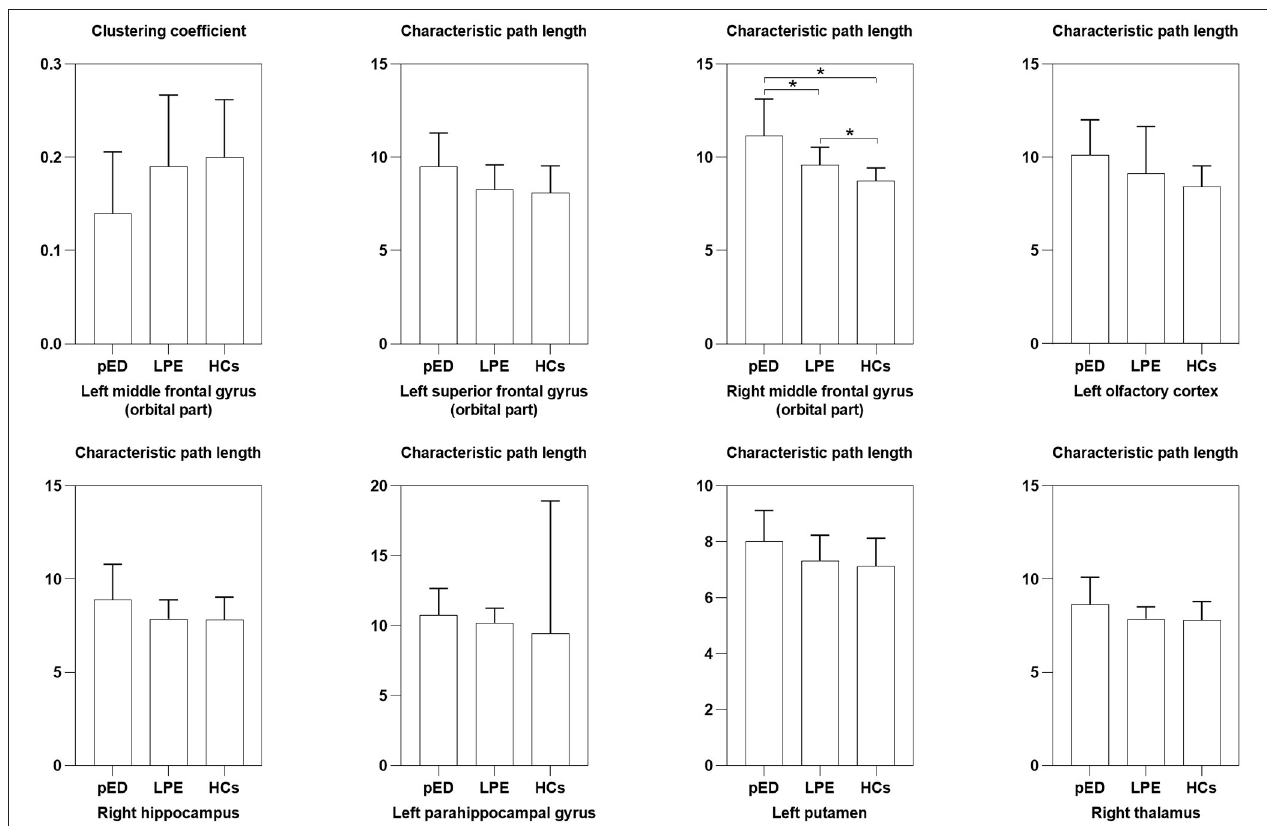
FIGURE 3 | Differences of nodal segregative and integrative parameters among the three groups. pED, psychological erectile dysfunction; LPE, lifelong premature ejaculation; HCs, healthy controls. *Significant differences between two groups detected by two-sample t -test. P < 0.01 was considered as statistically